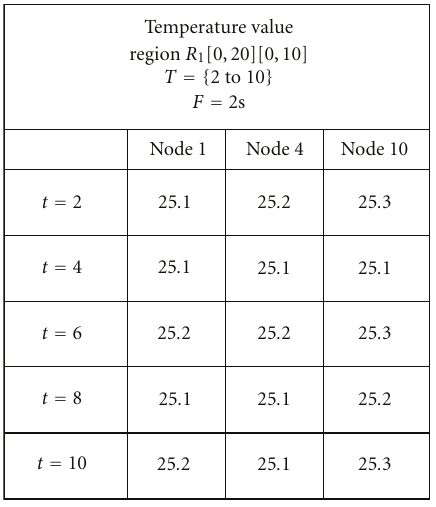
Figure 4: An example storage structure for historical